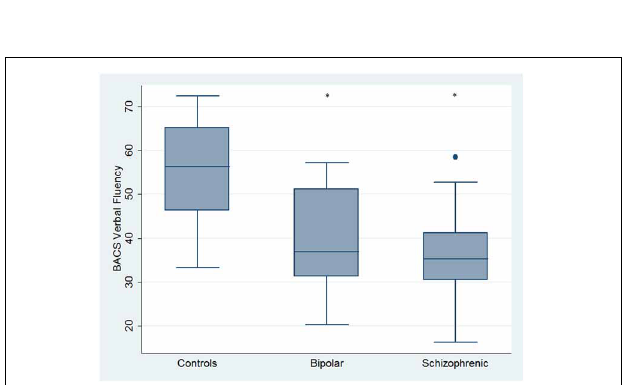
FIGURE 5 | Differences between groups in neuropsychological tasks: BACS verbal fluency. • Outliers. ∗ Significantly different from HC ( p < 0 . 05).